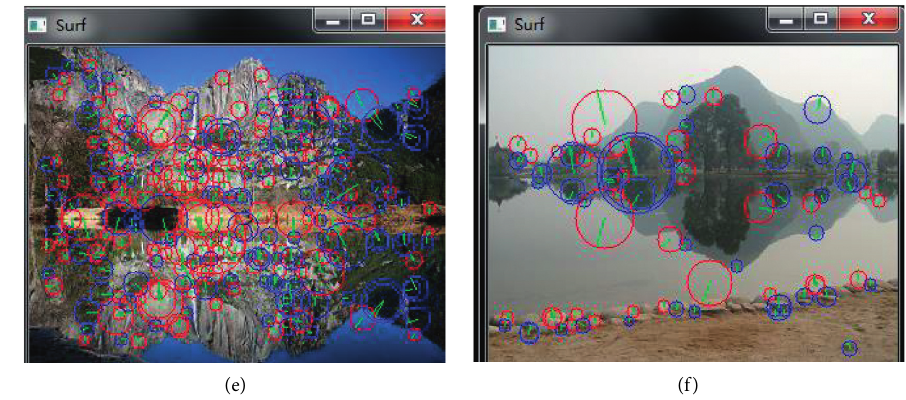
Figure 13: Symmetrical SURF points detection results.